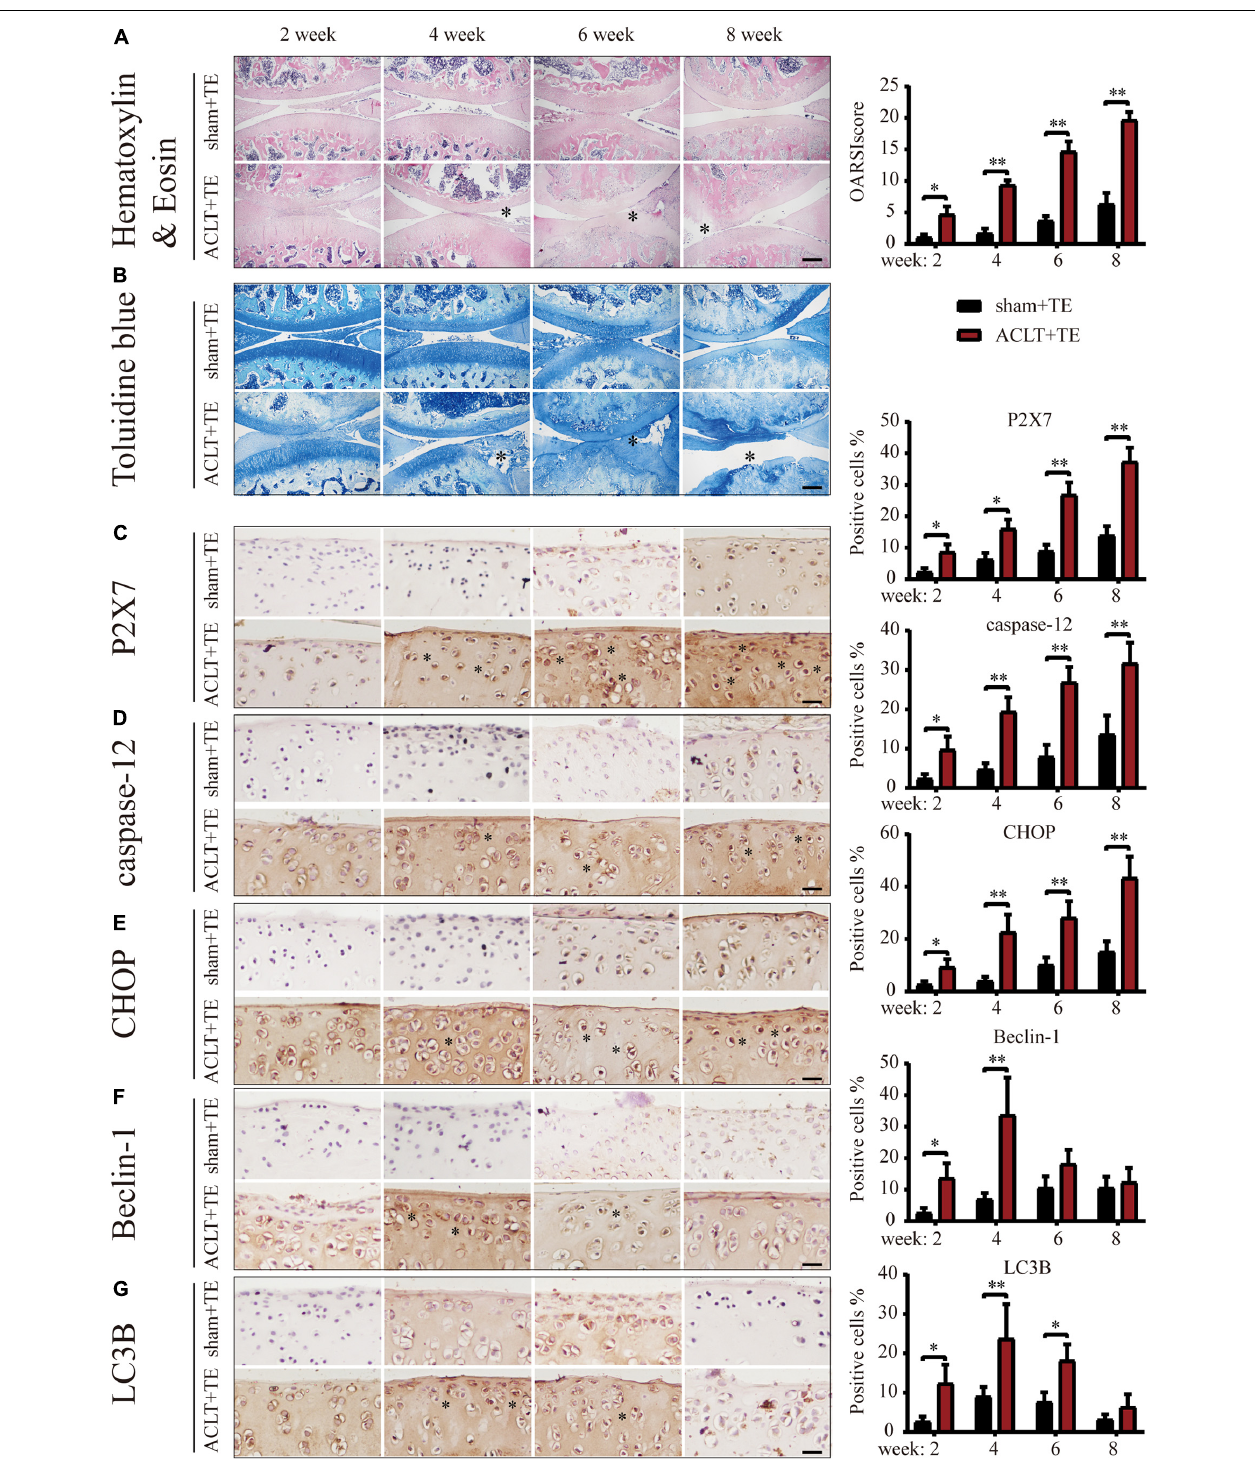
FIGURE 1 | Effect of treadmill exercise on P2X7, autophagy, and apoptosis markers. H&E (A) and TB (B) staining of the sagittal sections of the knee joint tissue. The degree of cartilage loss and matrix degradation from 2–8 weeks (scale bar: 500 µ m) was calculated using the Osteoarthritis Research Society International (OARSI) scoring system (see quantification on the right). (C–G) IHC staining and quantification. Expression level of (C) P2X7, the apoptosis markers caspase-12 (D) and CHOP (E) , and the autophagy markers LC3B (F) and Beclin-1 (G) over time (scale bar: 200 µ m). Quantification of the stained cells is presented on the right. The asterisk in the HE and TB staining images represents the cartilage damage site, and the asterisk in the histochemical images represents the positively stained cells. Data are expressed as means ± standard deviations of at least three independent experiments. ∗ p < 0.05, ∗∗ p < 0.01.